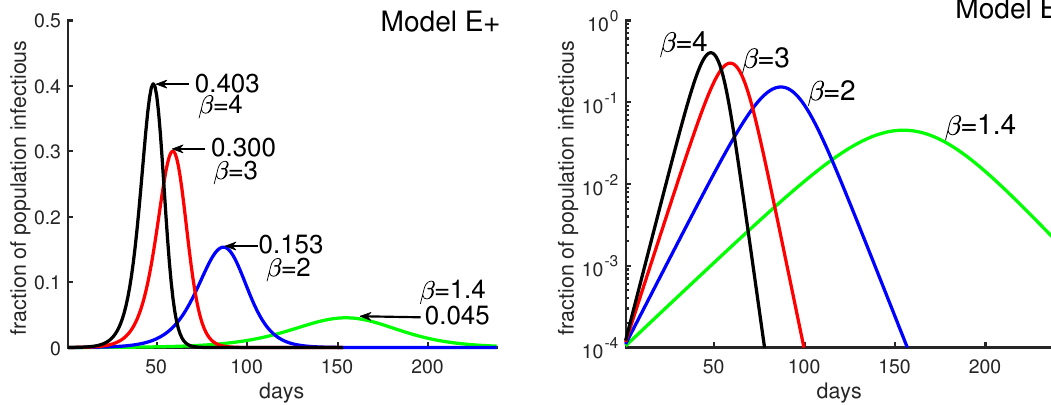
Figure 3. Obtaining daily reports from Model E+. Model E+ was run for β = 1.4,2,3 , and 4 . Each point on the curves is the infectious fraction for the preceding 7 days, with the horizontal axis being the number of days. The numbers in the graph show each outbreak’s peak-week infectious fraction. To get a smooth curve here and in the previous figure with daily results, we have run Model E+ seven times for each curve, as follows. Early in the outbreak, the fraction of infectious increases by the factor β per week, i.e., β 1/7 per day. For each β , the simulation was run seven times with initial infectious β j /7 , j = 0,1, . . . ,6 , and the plot was shifted to the right by j days, i.e., j 7